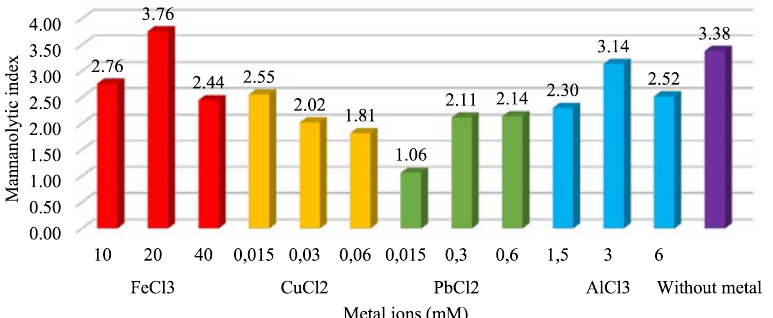
(10mM, 20mM, 40mM), CuCl 3